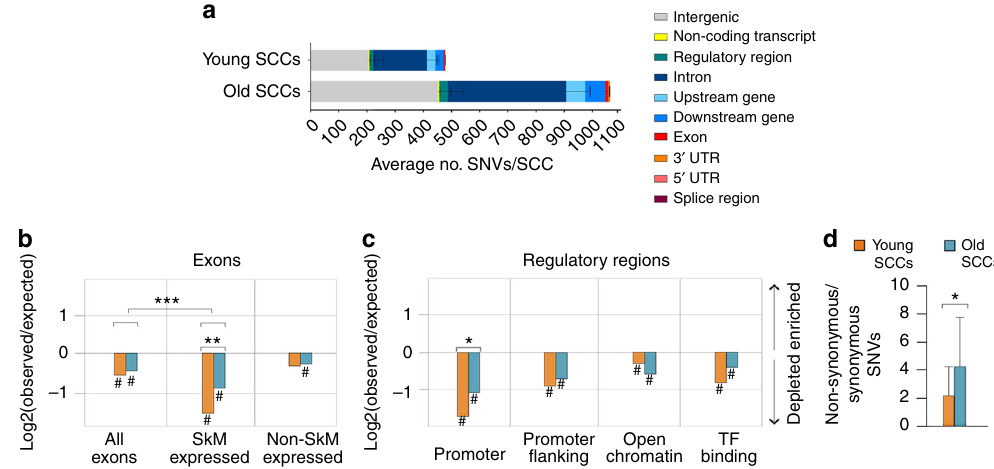
Fig. 2 Non-random genomic distribution of somatic SNVs in the genome of SCCs. a SNV distribution in annotation classes according to the Ensembl Variant Effector Predictor. The graph represents the absolute numbers of SNVs per clone as the mean ± standard error for young and old SCCs. b , c Depletion of somatic SNVs in the indicated genomic regions in young and old SCCs. The list of skeletal muscle (SkM) expressed and non-expressed genes was obtained from the Human Protein Atlas (http://proteinatlas.com). The log 2 ratio of the number of observed and expected point mutations indicates the effect size of the enrichment or depletion in each region. # P < 0.05, one-sided binomial test. ** P < 0.01 *** P < 0.001 two-sided t -test of speci fi ed log2 ratios. d Non-synonymous/synonymous ratio of coding SNVs for young ( n = 10) and old ( n = 14) SCCs. * P < 0.05 Mann – Whitney non- parametric